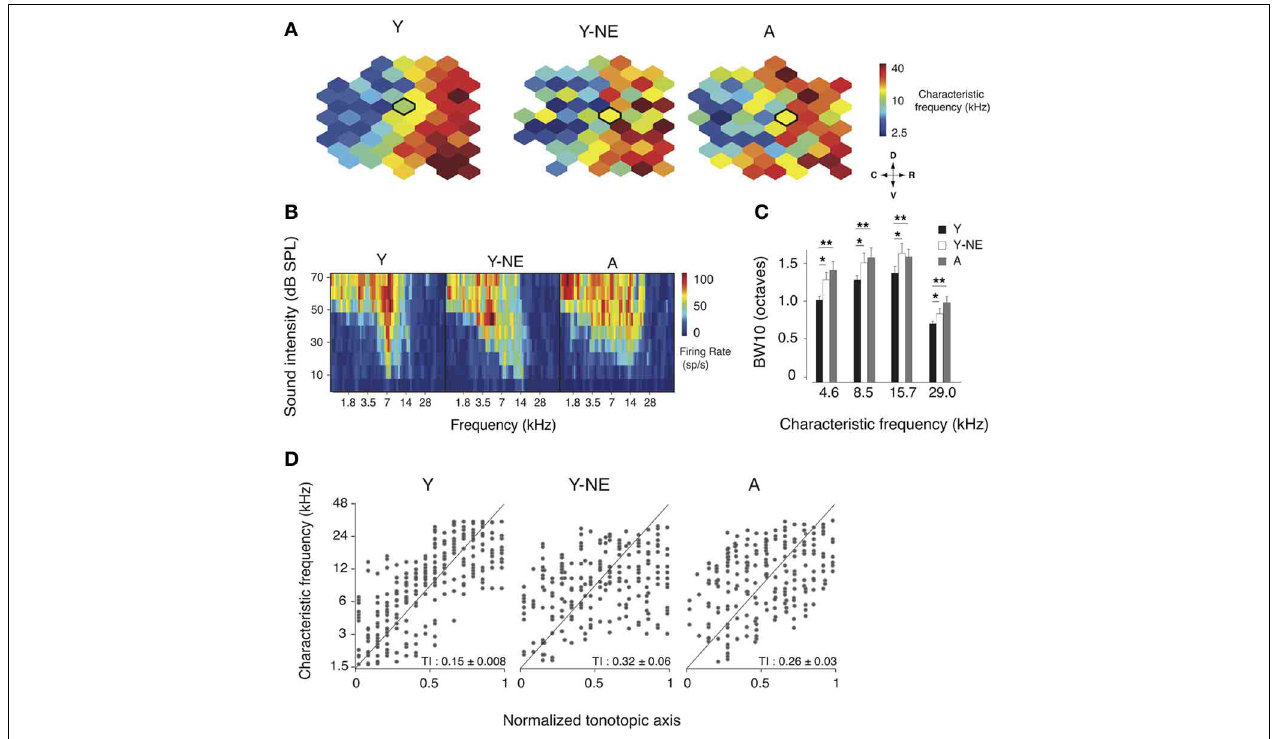
FIGURE 1 | Changes in frequency representation in the noise-exposed and aged A1. (A) Representative A1 CF maps from the young (Y), young noise-exposed (Y-NE) and aged (A) experimental groups. (B) Representative cortical receptive fields (RFs) obtained for the neurons recorded in the center of the bolded polygons in the respective maps shown in A. (C) Average BW10 for all neurons